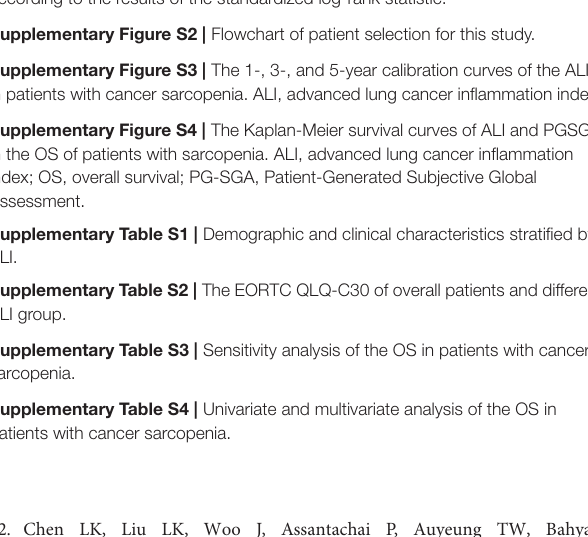
Supplementary Figure S1 | Optimal cut-off value of inflammation markers according to the results of the standardized log-rank statistic. Supplementary Figure S2 | Flowchart of patient selection for this study. Supplementary Figure S3 | The 1-, 3-, and 5-year calibration curves of the ALI in patients with cancer sarcopenia. ALI, advanced lung cancer inflammation index. Supplementary Figure S4 | The Kaplan-Meier survival curves of ALI and PGSGA in the OS of patients with sarcopenia. ALI, advanced lung cancer inflammation index; OS, overall survival; PG-SGA, Patient-Generated Subjective Global Assessment. Supplementary Table S1 | Demographic and clinical characteristics stratified by